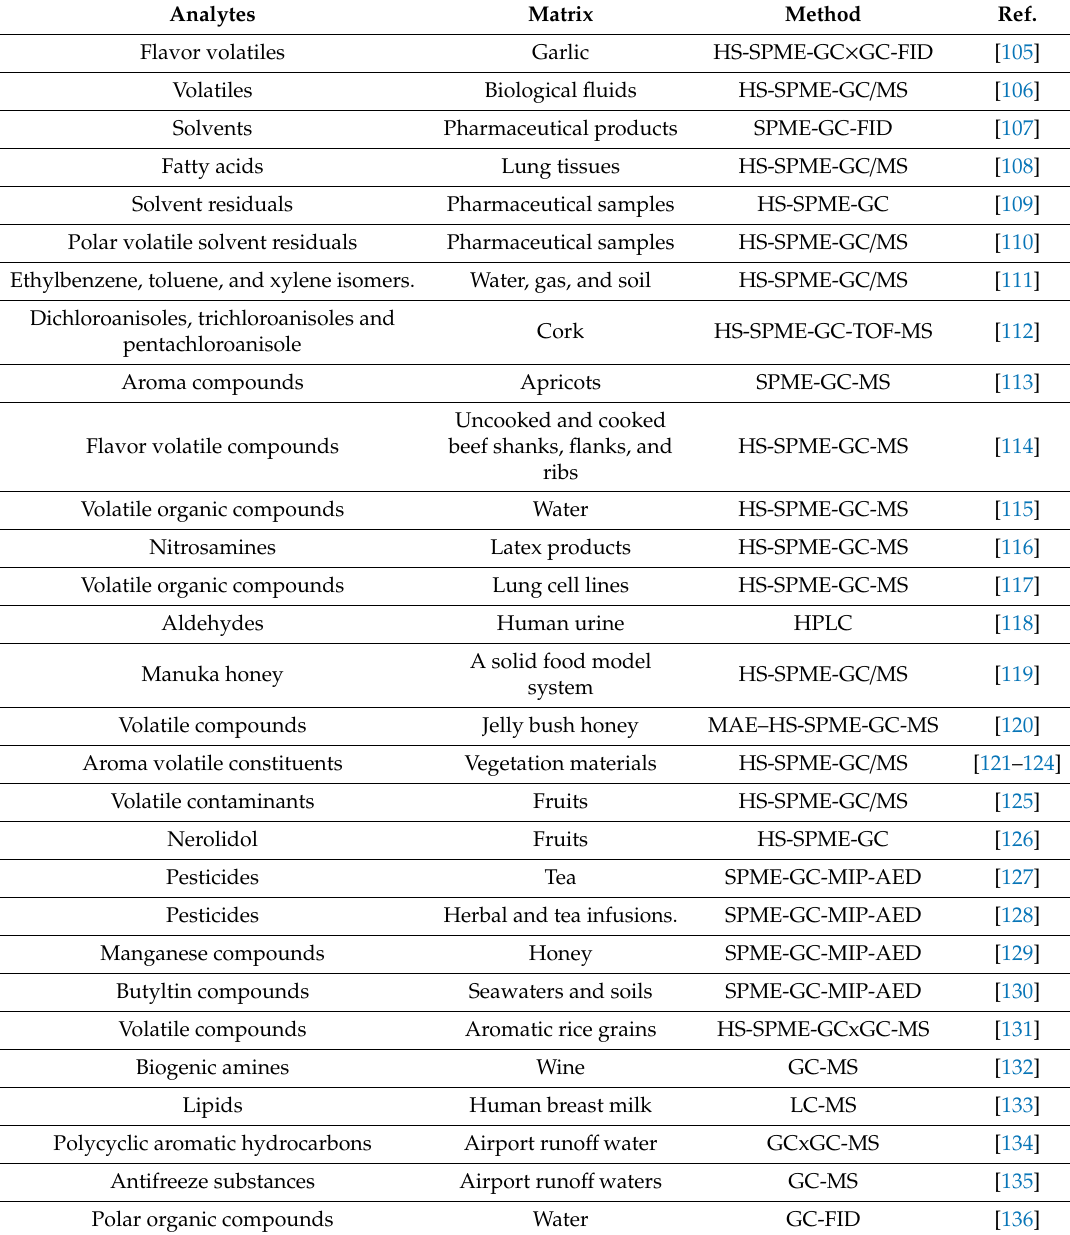
Table 2. Examples of solid phase microextraction SPME applications in the analysis of various